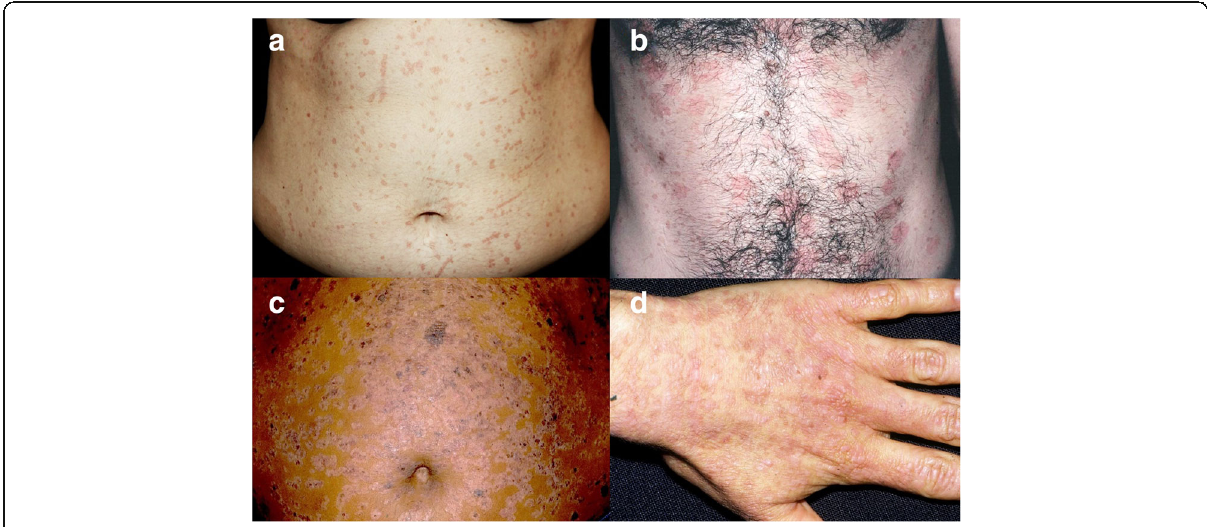
Fig. 1 Examples of clinical presentation of epidermodysplasia verruciform a Multiple flat warts lesions on trunk (note pseudo Koebner). b Pityriasis versicolor-like macules on trunk. c Multiple seborrheic keratoses associated with pityriasis versicolor-like lesions. d Flat warts on the dorsal aspect of the